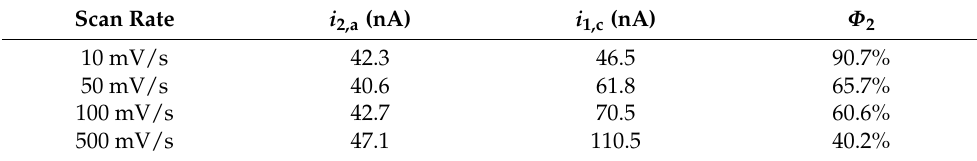
Table 2. NRE 2 collection